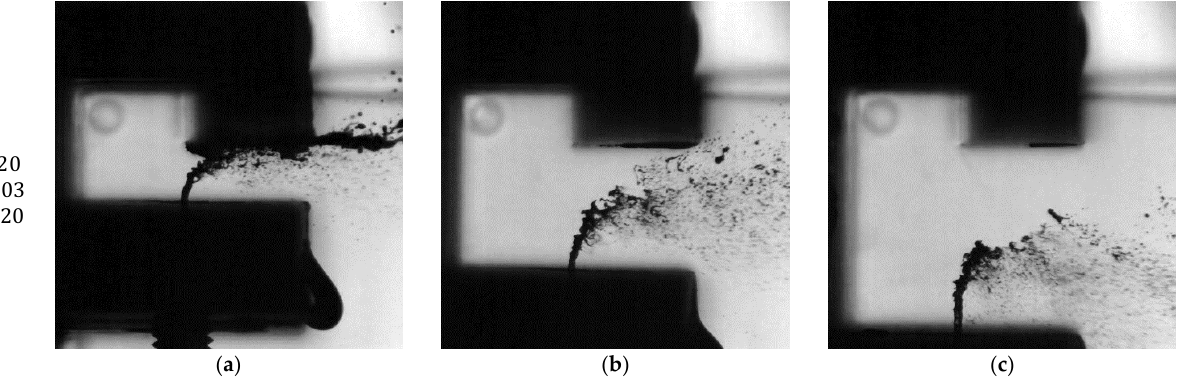
Figure 14. Instantaneous jet images for three different outlet heights: ( a ) H / d 0 = 10; ( b ) H / d 0 = 20; and ( c ) H / d 0 = 30.